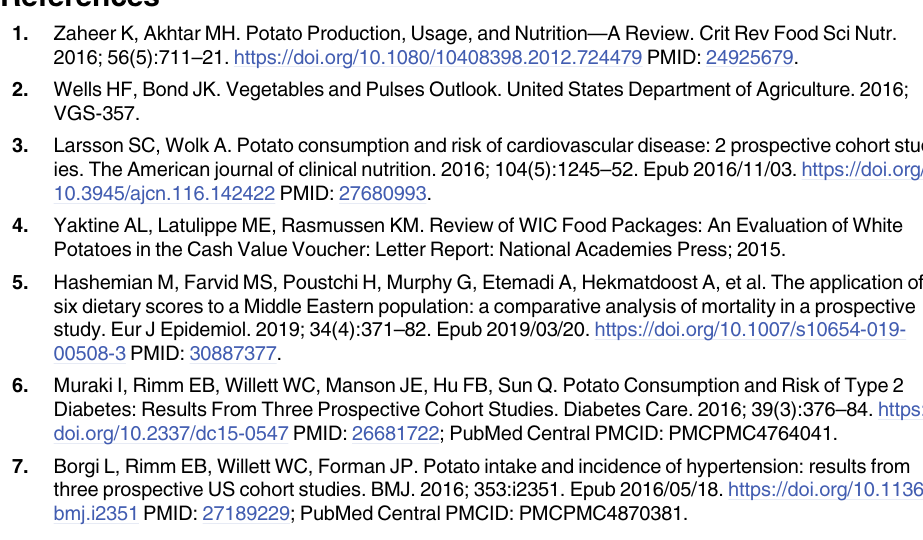
S1 Fig. Participant flow chart. S1 Table. Demographic and dietary characteristics of participants by different types of potato preparation in the NIH-AARP Diet and Health Study